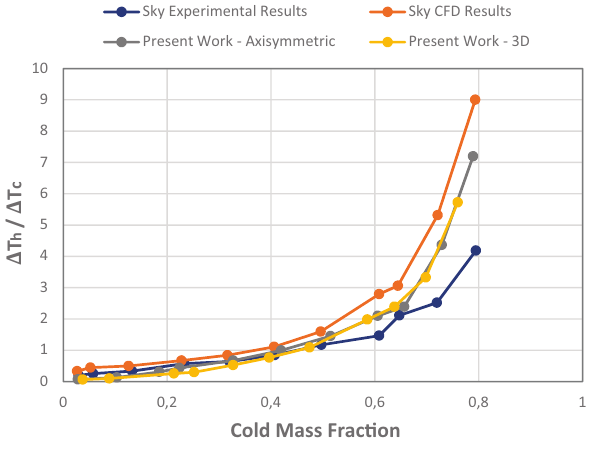
Figure 7. Ratio of hot ( h T ∆ ) and cold ( c T ∆ ) temperature difference versus the cold mass fraction ( λ )